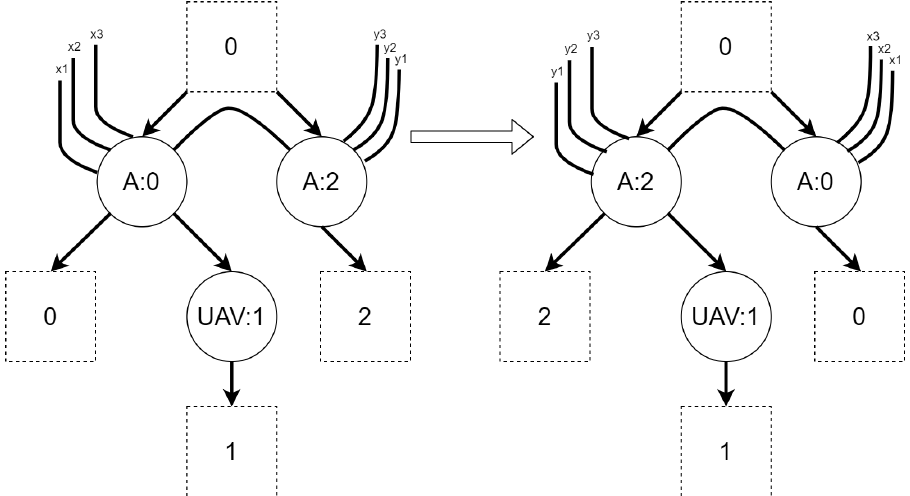
Figure 8. Reaction rule move for scenario 2.